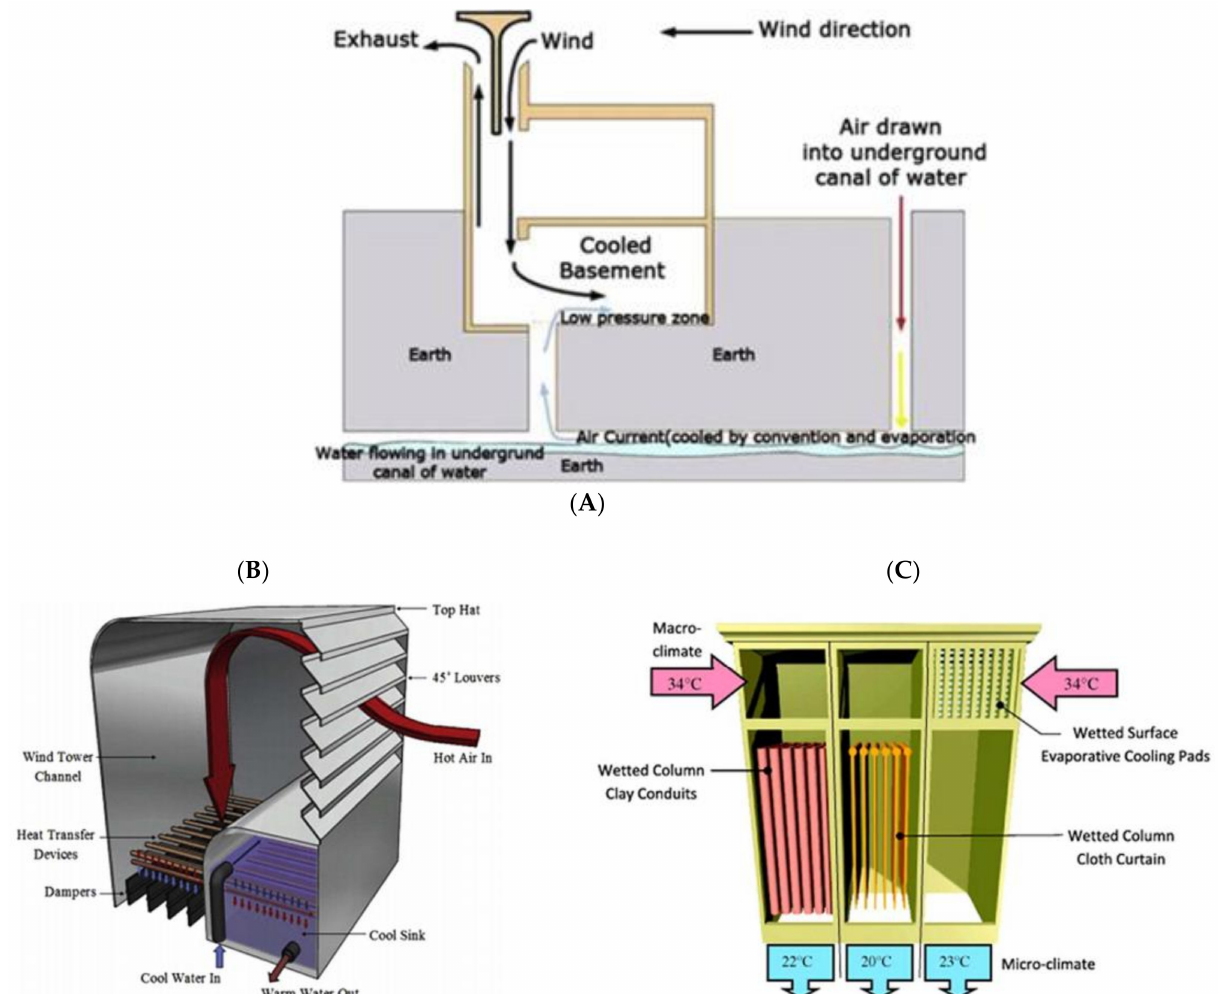
Figure 1. Old and traditional wind catcher in the Middle East ( A ), modern systems of wind catchers where ( B ) is used in an operating heat transfer system, and ( C ) is a thermal operation integrated with wetted columns. Reprinted from Ref.